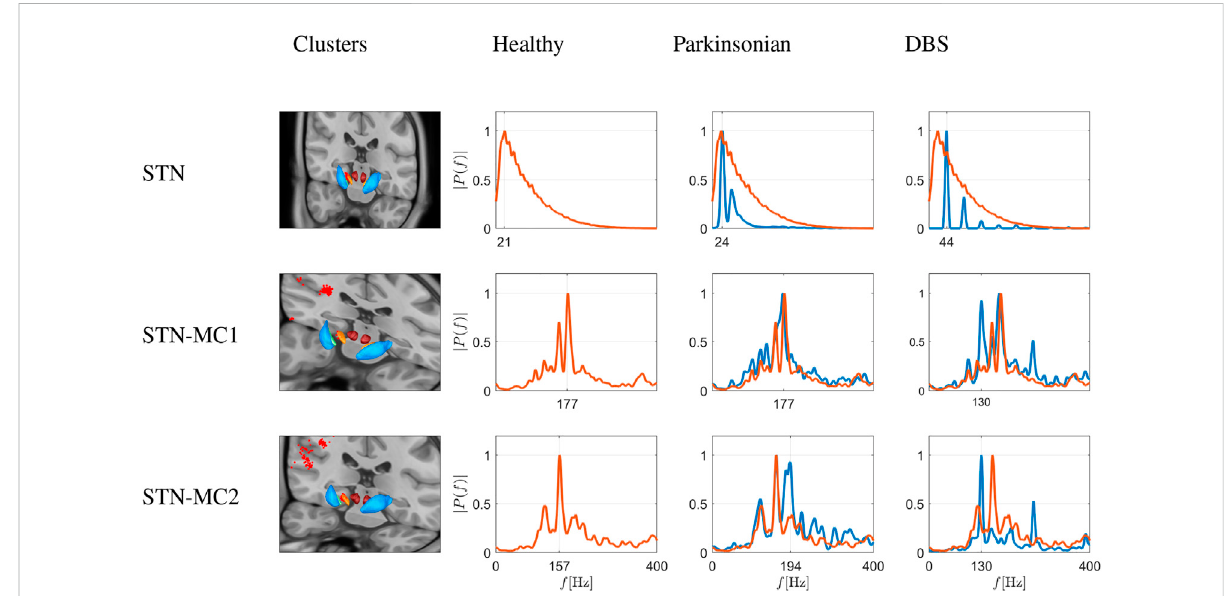
FIGURE 10 Simulation of frequency spectrograms of the STN (top row) and the hyperdirect pathway connections (two bottom rows) as average neuronal activity(poweronordinategivenasrelativevalue)inafrequencyrangeof0 – 400 Hz.Thethreerowsthusdepictnodesetsemergingfrommodularity analysis in the STN itself (top), and in nodes connecting MC and STN, i.e., two clusters of connections involving the hyperdirect pathway (middle and bottom), depicted as red dots on the virtual brain sections. The spectrograms correspond to healthy conditions (red traces), Parkinsonian conditions and DBS in a Parkinson-affected network (both as blue traces), as shown in the different columns. Traces from healthy conditions are superimposed as fi ne red traces. Under healthy conditions, in a set of STN nodes quite different from the one projecting to the GPe of the previous fi gure,theactivityisalsodistinctlydifferentasitpeaksat21 Hz,withaverywidefrequencydistributionintohigherfrequencies.Thesenodesprobably relatetothehyperdirectpathway,astheyareclosetothenodesofthesecondrow,i.e.,MC-STNconnections.Inthelatter,underhealthyconditions, peakactivityemergesat ≈ 160 – 180 Hz,i.e.,inthehigh γ range.UnderParkinsonianconditions,STNnodesnarrowdowntheirspectrumtotwopeaks (at 44 and 86 Hz), and a loss of the wide spectral activity. Under DBS, in the STN nodes a wider distribution of frequencies appears again, albeit as an appearance of peaks at harmonic frequencies of 44 Hz (44, 88, 172 Hz). In the hyperdirect pathway related nodes, however, DBS does not change much intheactivity, save appearance ofa130 Hzpeak(thenstimulatingfrequency).Inthe fi rst cluster(middle),thefrequency distribution otherwise remains more or less similar, and in the second cluster (bottom), the 160 Hz peak is